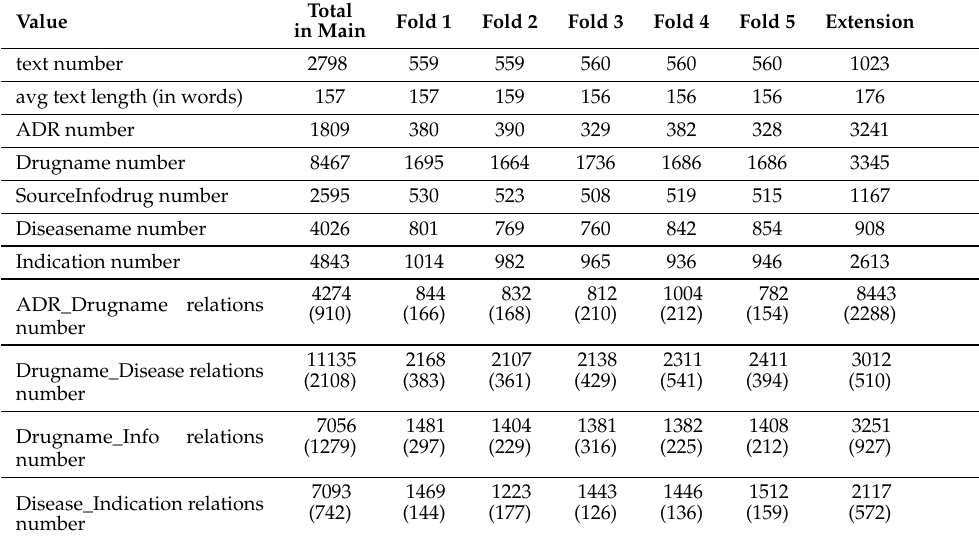
Table 2. Statistics on the main and extended corpora. Total in main—the sum of 5 folds without an extended part of the RDRS datset. For the relations number, the number of related entities of this type is indicated, and in brackets the number of unrelated